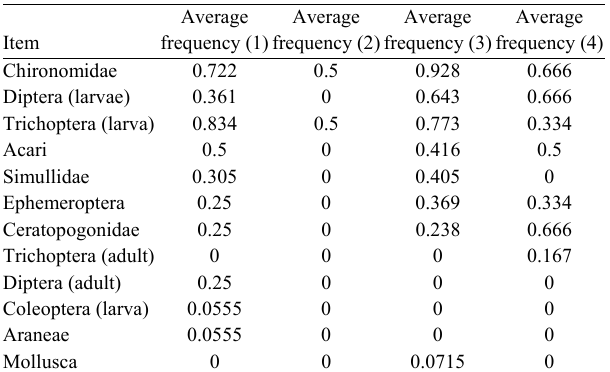
Table 2. Average frequency of occurrence of invertebrate groups among the stomach contents in the four